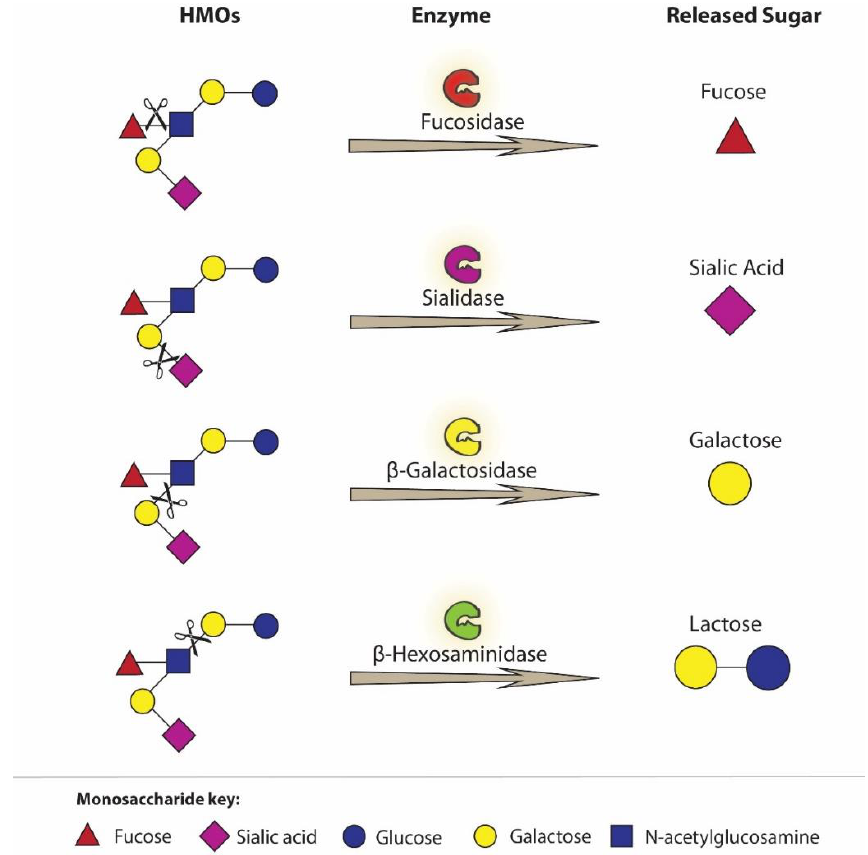
Figure 2. Bifidobacteria species present in infant gut encoding different glycosidases, responsible for cleaving individual monosaccharide units from HMOs [85,91 – 93]. HMOs, human milk oligosaccharides.